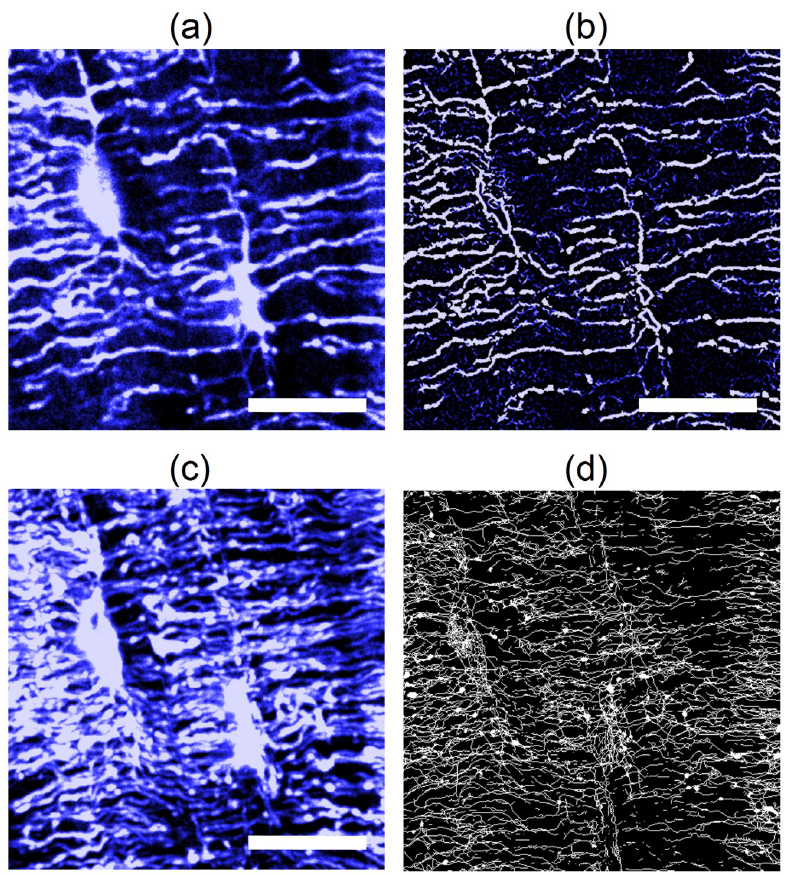
Fig 3. Image processing pipeline. (a) Zoom of a region of interest of a THG image at 3.6 μm from the surface. (b) Corresponding image after vesselness filtering. (c) Intensity projection of the full image stack along Z. (d) Maximum intensity projection of the result of the skeletonization of the filtered data. Scale bar 20 μm